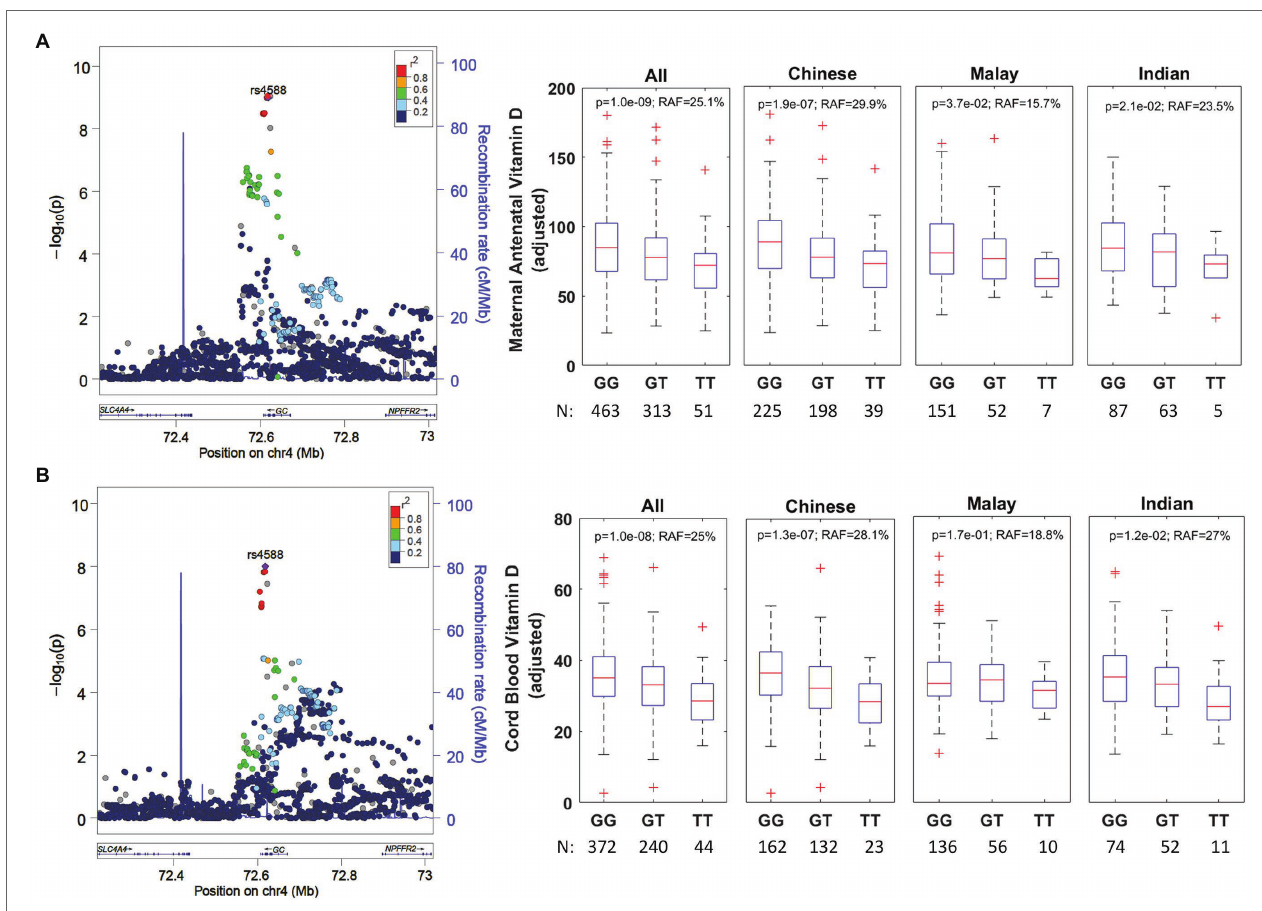
FIGURE 2 | (A) Regional association plot for rs4588 group-specific component ( GC ) and ethnicity-stratified levels for antenatal vitamin D. The regional association plot (left) is based on all individuals with complete data for analysis. The data presented as boxplots (right) has been adjusted for ethnicity, mother’s age at recruitment and consumption of vitamin D containing supplements. RAF, risk allele frequency. (B) Regional association plot for rs4588 ( GC ) and ethnicity-stratified levels for cord blood vitamin D. The regional association plot (left) is based on all individuals with complete data for analysis. The data presented as boxplots (right) has been adjusted for ethnicity and antenatal vitamin D